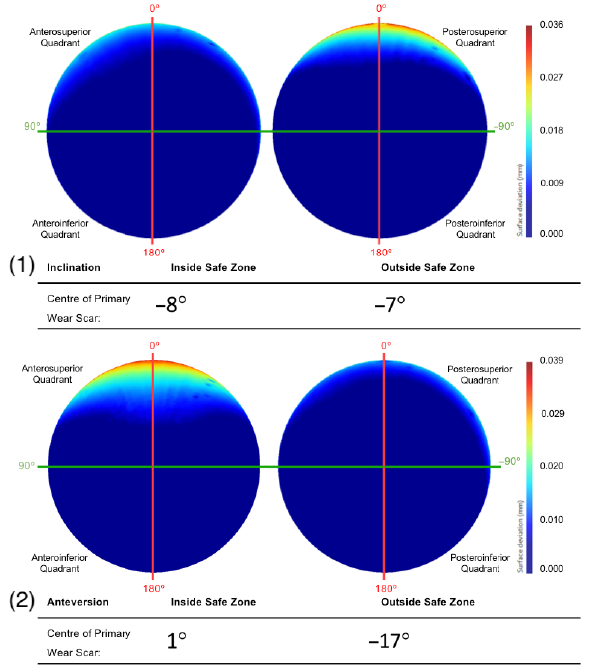
Figure 9. The mean surfaces generated following the subdivision of the acetabular surface, based on their (1) inclination and (2) anteversion angles. This is presented as deviation maps of their comparison with the as-manufactured reference surface (mm). Female patients had a mean primary wear scar centre of 1°, while male patients had mean wear scar centre of −5 6° (Figure 10). The implants that were sized 52 mm and below had a mean wear scar that was centred about a 0° angle, while the larger sizes had a wear scar centre of −5 0° (Figure 10).